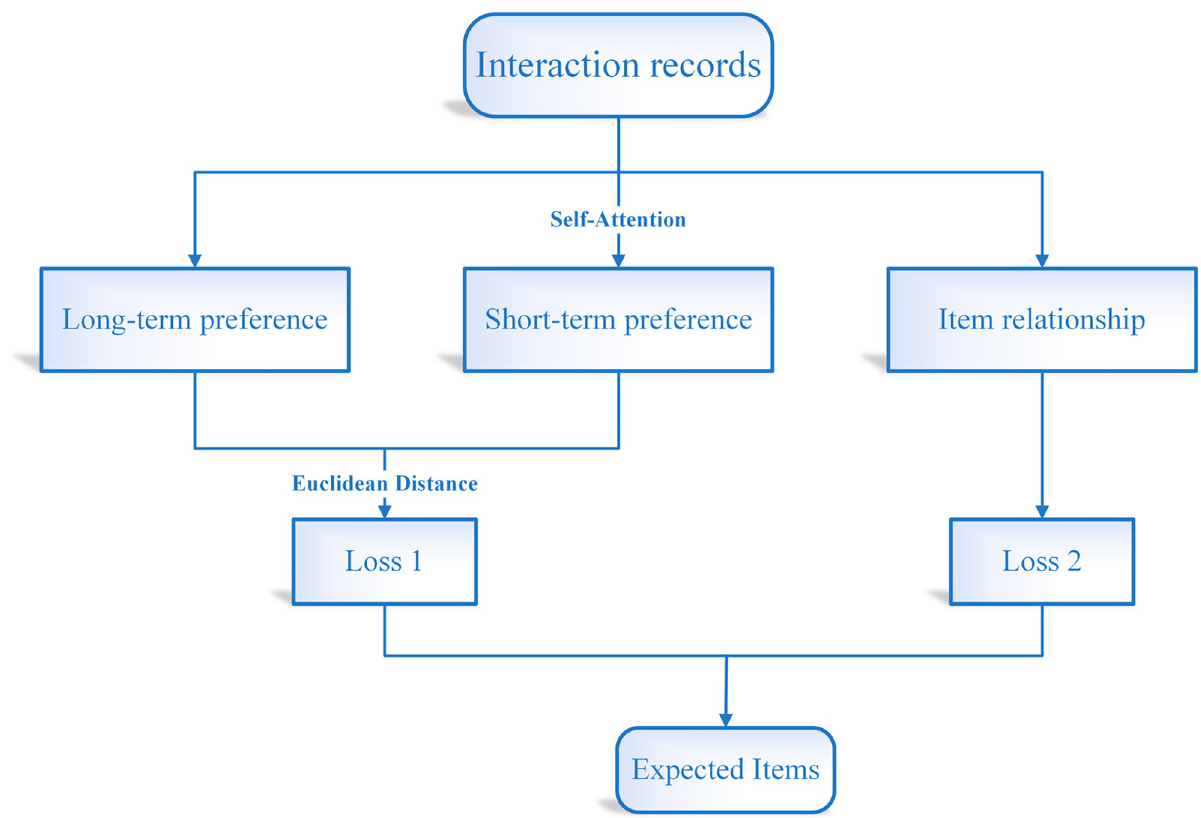
Fig 1. Frame diagram for this paper. The left part of the figure models the user’s long- and short-term intentions, of which the short-term intentions are derived from the self-attention mechanism. The right half of the figure models the item relations.